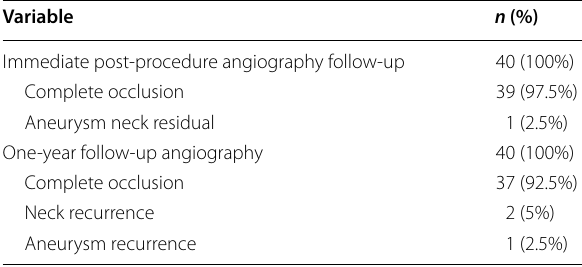
Table 1 Summary of study results